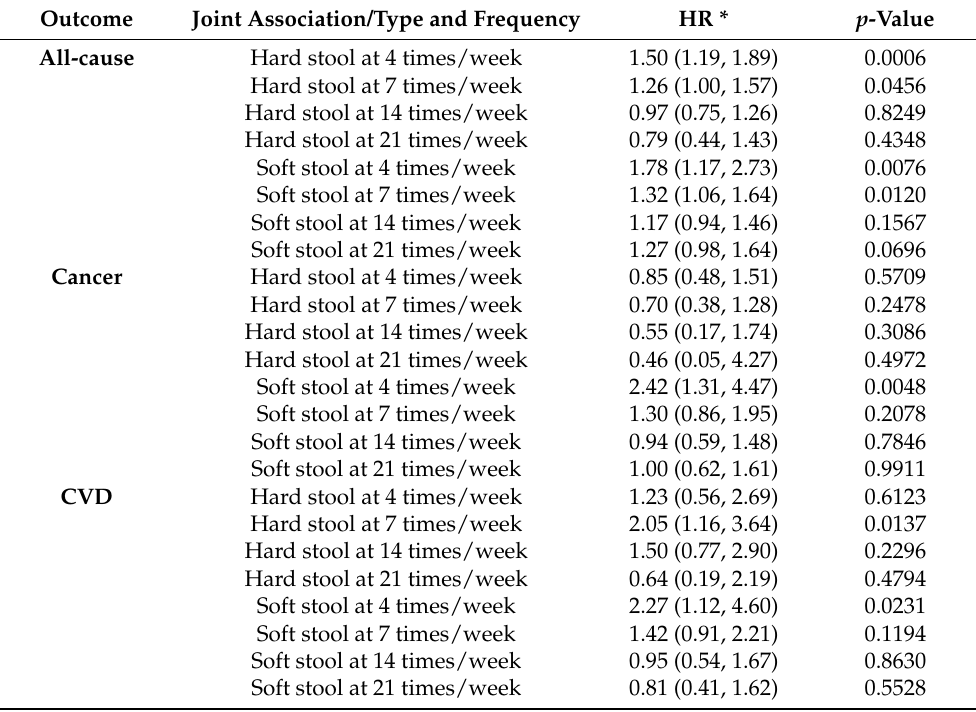
Table 4. Joint associations of the stool frequency and stool consistency with all-cause, cancer, and CVD